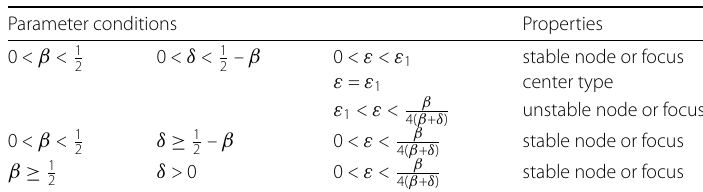
Table 1 Properties of ( x 4 , y 4